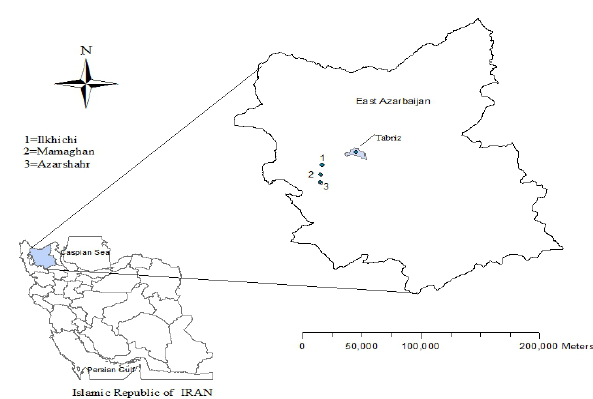
Fig. 1. Location of three studied cities in the